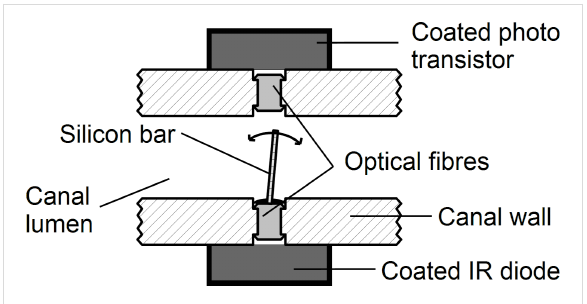
Figure 8: Scheme of an artificial CN. The drawing is not to